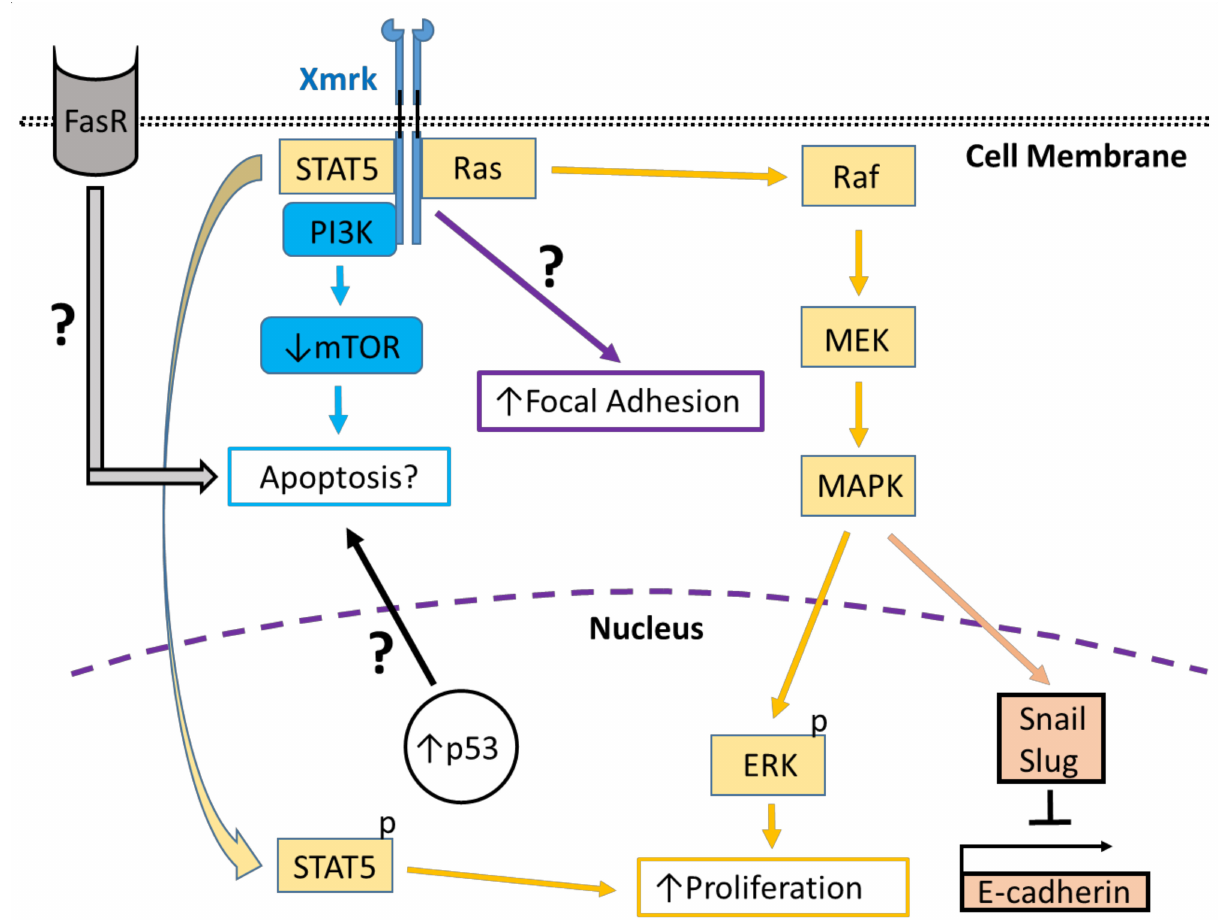
Figure 2. Xmrk signaling in the zebrafish hepatocellular carcinoma model. In transgenic zebrafish models of HCC, Xmrk signals through kinases and transcription factors that modulate liver cancer progression. PI3K activation may modulate apoptosis through the mechanistic target of rapamycin (mTOR), although mTOR expression may be decreased in HCC, making its effect on apoptosis uncertain. STAT5 signaling can promote proliferation, as does MAPK via activation of extracellular signal-regulated kinases (ERK). MAPK also has a dual role in signaling through the transcription factors, Snail and Slug, to inhibit E-cadherin activity. The formation of focal adhesions is increased through a pathway that is currently uncharacterized. Xmrk is also associated with increased expression of the tumor suppressor, p53, and the Fas receptor (FasR), which regulates apoptosis during HCC, but the details of their associated signaling mechanisms are not currently